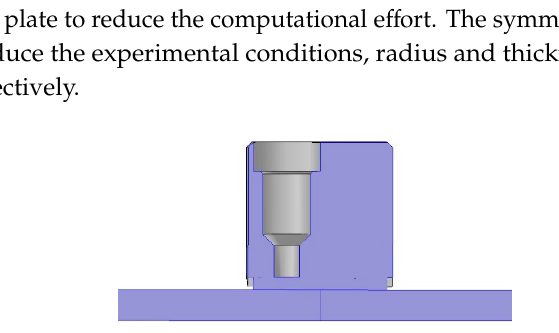
Table 2. Material properties used for FEA